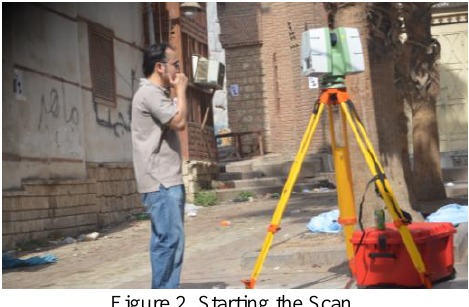
Figure 2. Starting the Scan.